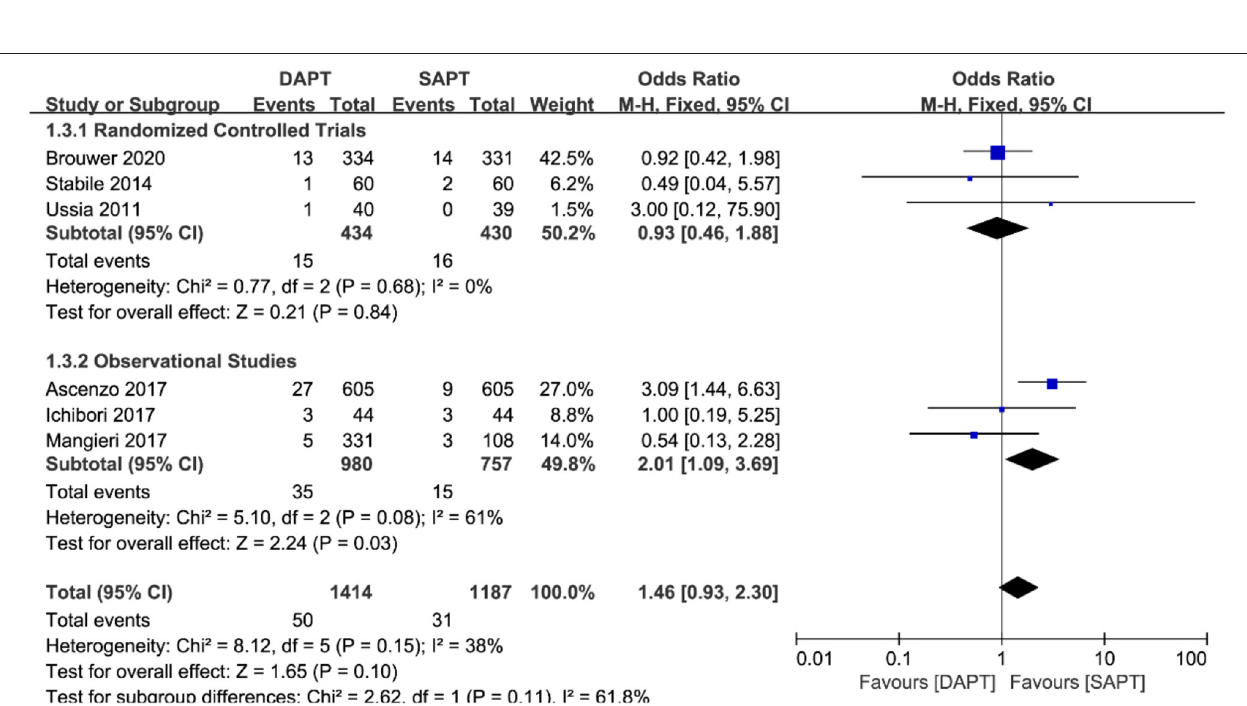
FIGURE 5 | Forest plot for cardiovascular mortality with subgroup analysis stratified by study type at longest follow-up.